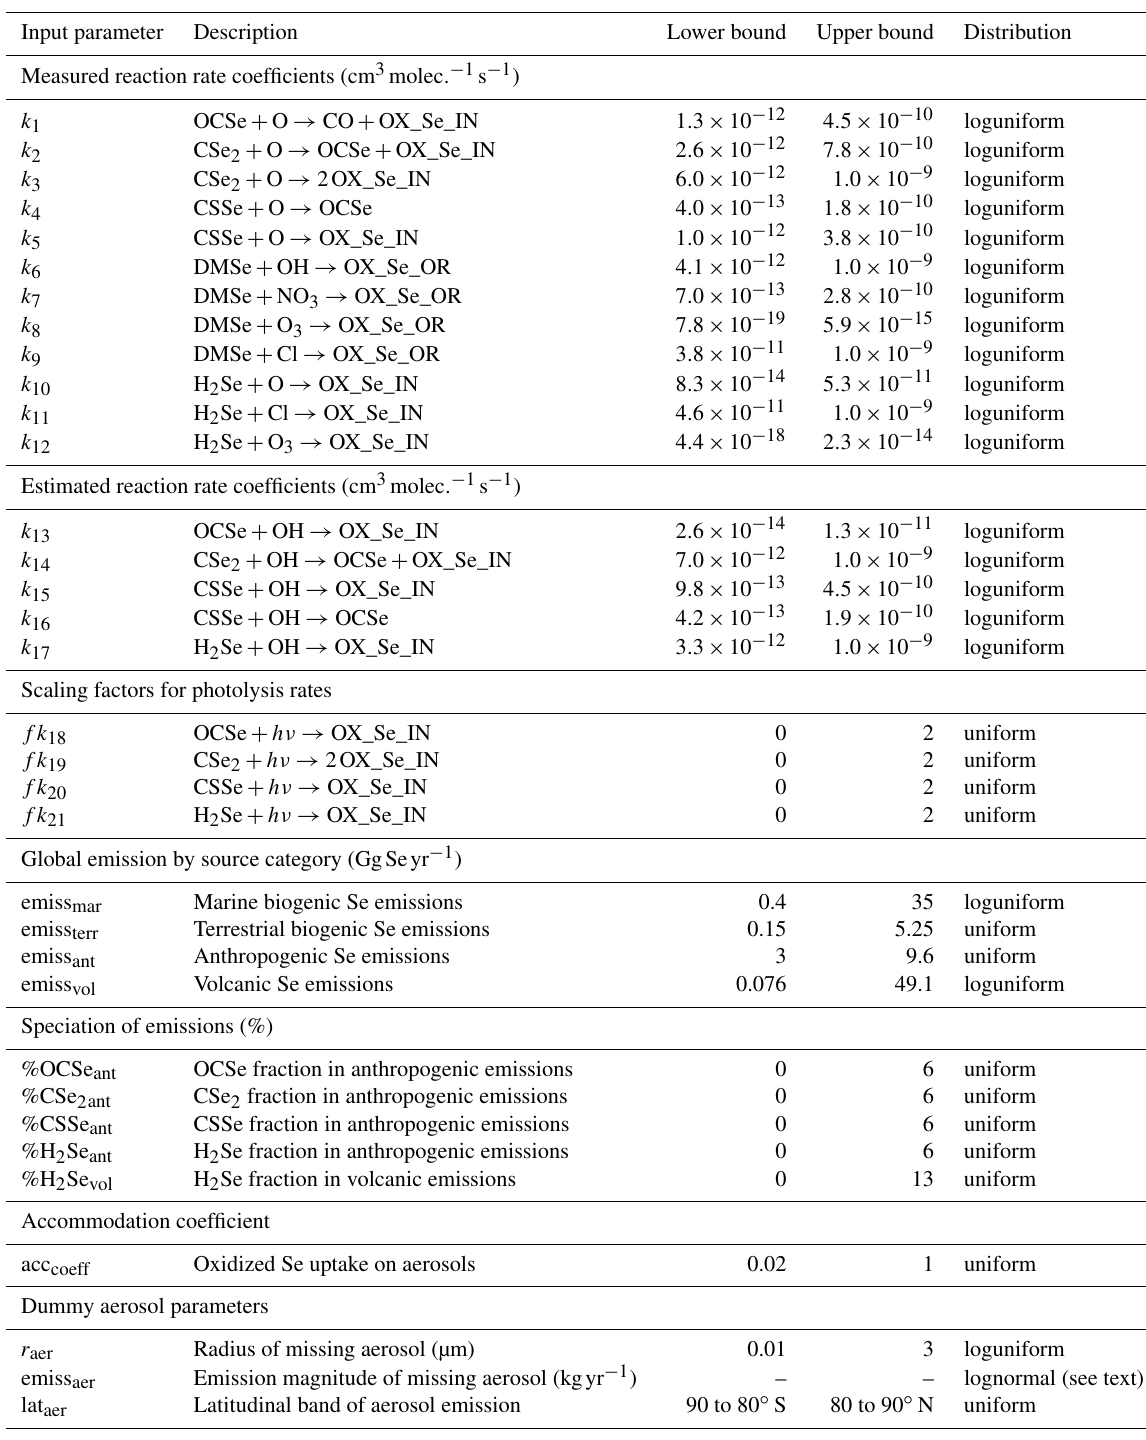
Table 3. Probability distributions of the model input parameters selected for the sensitivity